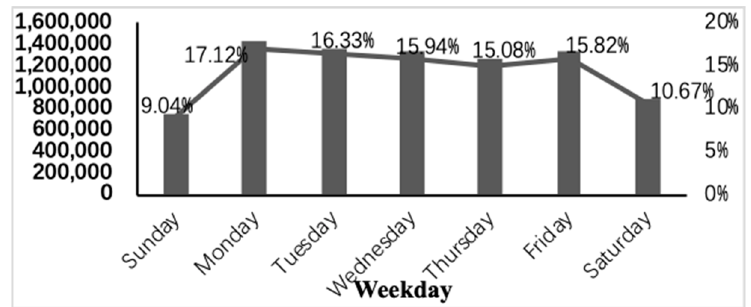
Figure 2. Weekend effect.